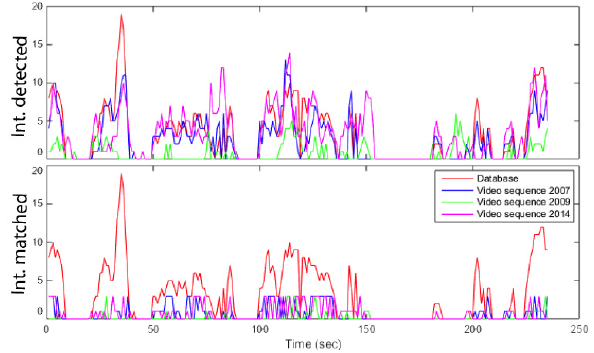
Figure 15: The number of features detected and matched with